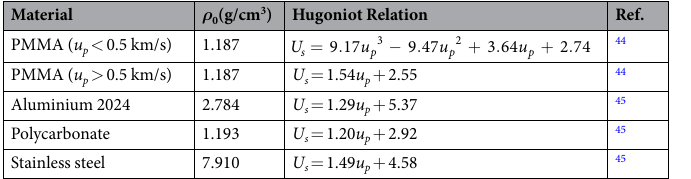
Table 1. The U s - u p Hugoniot for each material, used to calculate the shock